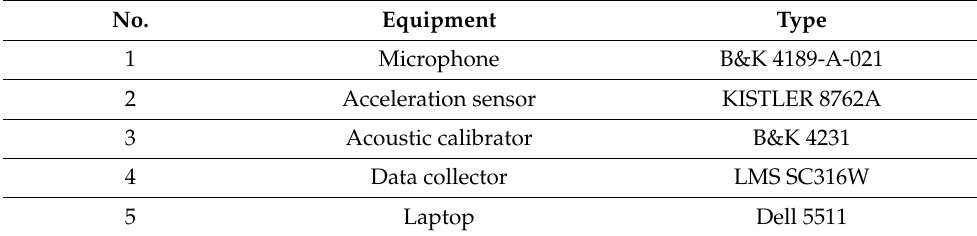
Figure 17. Arrangement of noise source excitation points on the left front suspension. Table 4. Structure-borne noise source excitation measurement